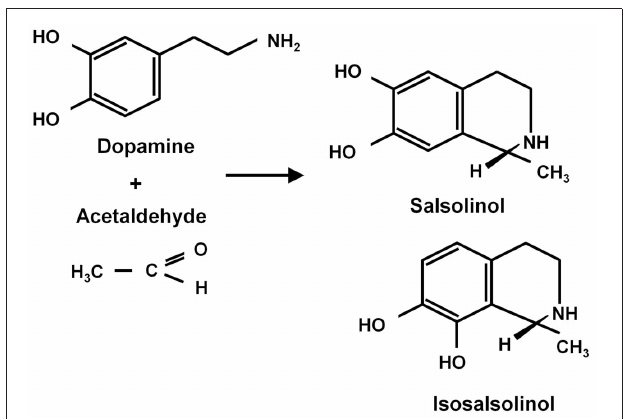
FIGURE 1 | Acetaldehyde condensation with dopamine. Products formed in the non-enzymatic condensation are (R)- and (S)-salsolinol and (R)- and (S)- isosalsolinol (from Juricic et al.,